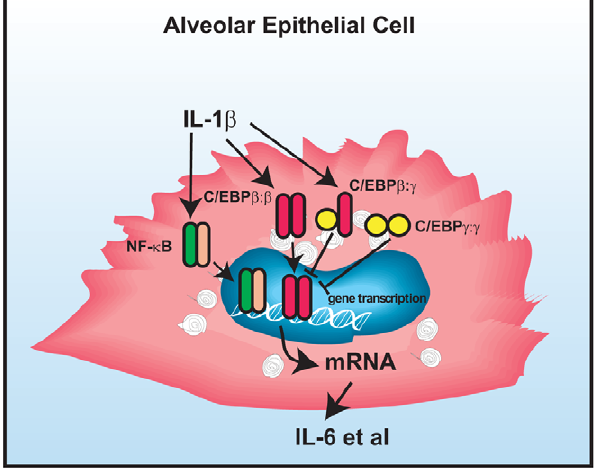
Figure 8. Diagram delineates a role for C/EBP c in the AECII inflammatory responses. Inflammatory stimuli in the lung such as IL- 1 b trigger activation of AECII. AECII activation is characterized by increased nuclear translocation, DNA binding of transcription factors such as NF- k B and C/EBP b , and subsequent production of the pro- inflammatory mediators such as IL-6. This inflammatory response is endogenously regulated by the dominant-negative members of the same family of transcription factors such as C/EBP c by forming homodimmers themselves and heterodimmers with C/EBP b to compete with C/EBP b : b dimmers to bind to promoter